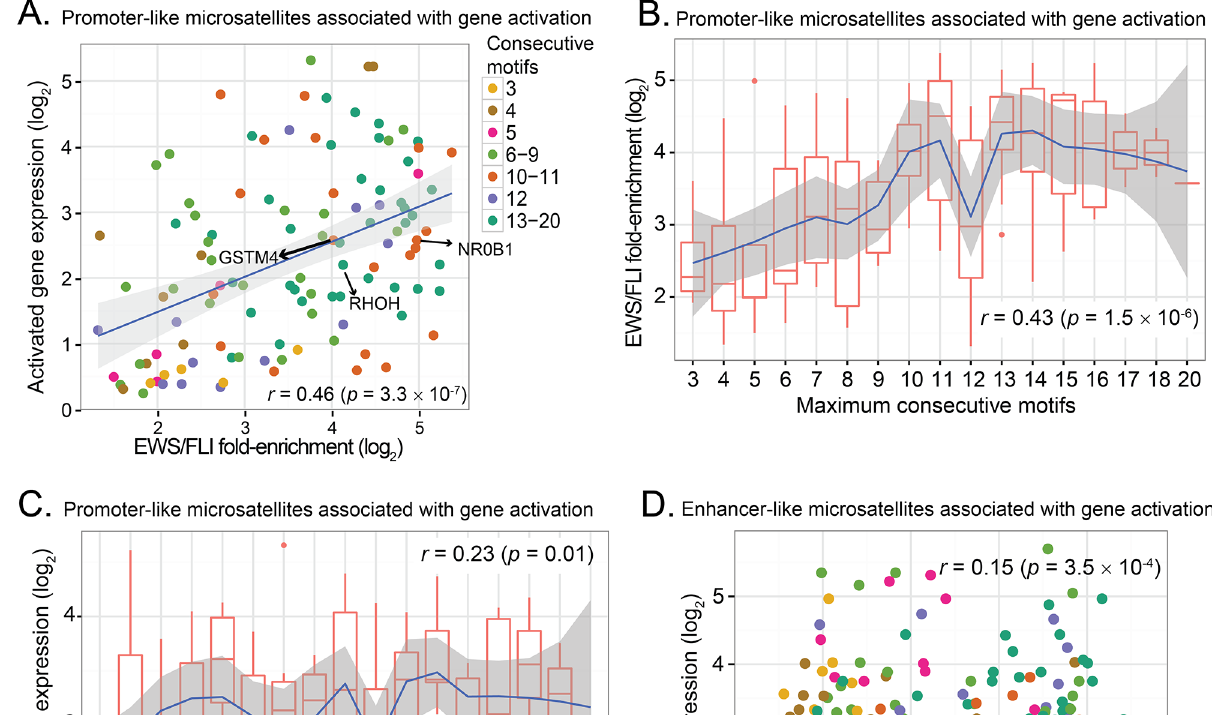
Fig 4. Correlation between EWS/FLI-bound microsatellites, GGAA-motif and gene expression. ( A ) Scatter plot of expressionof activated genes and EWS/FLI fold-enrichment at promoter-like microsatellites showinga positive correlation( r = 0.46, p = 3.35 × 10 − 7 ). ( B ) Boxplot of EWS/FLI fold-enrichment and number of consecutivemotifs of EWS/FLI-bound at promoter-like microsatellites for activated genes showinga non-lineartrend. Blue line is the estimated LOESS regression line of the mean with the estimated 95% confidenceinterval (shadedregion). Overall, there is statistically significantpositive correlation( r = 0.43, p = 1.5 × 10 − 6 ). ( C ) Boxplot of EWS/FLI-activated gene expressionand number of consecutive motifs at promoter-like EWS/FLI-bound microsatellites for gene activationshowinga non-lineartrend